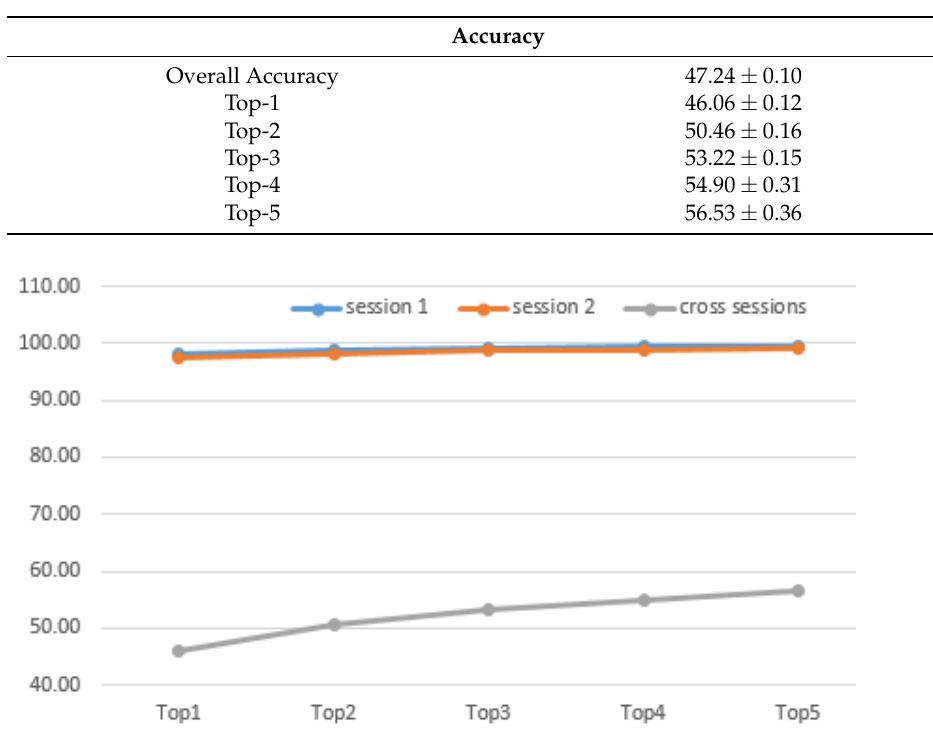
Table 5. The accuracy of the proposed system on the cross-session scenario.